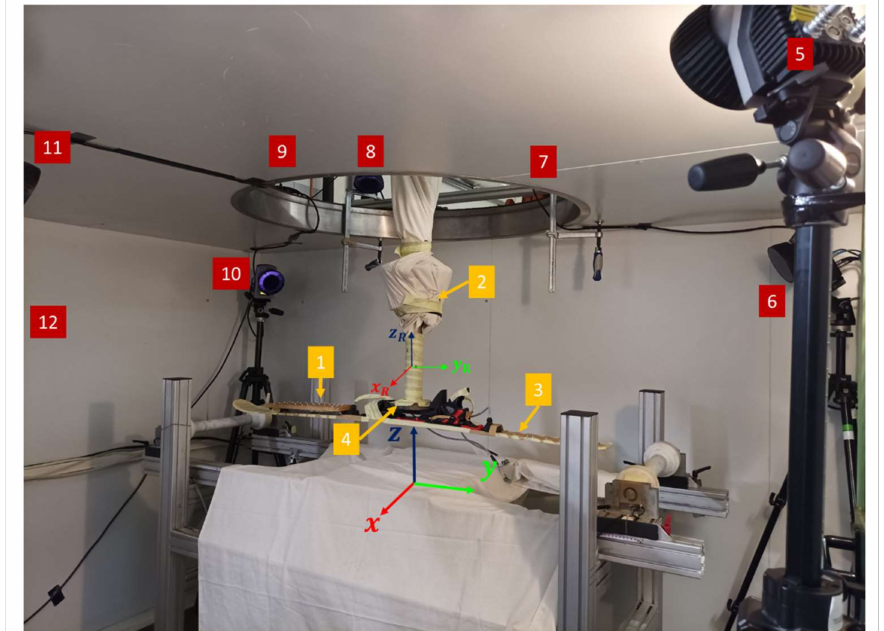
Figure 2. Experimental setup with the following components: 1: calibration profile with the instru- mented infrared markers; 2: industrial arm robot; 3: Alpine ski on which the calibration profile was fixed.; 4: connection of robot arm with Alpine ski (test shoe); 5–12: Qualisys system with infrared cameras; the positions of the infrared markers refer to the reference coordinate system (x, y, z) and additionally a robot arm coordination system (x R , y R , z R ) was